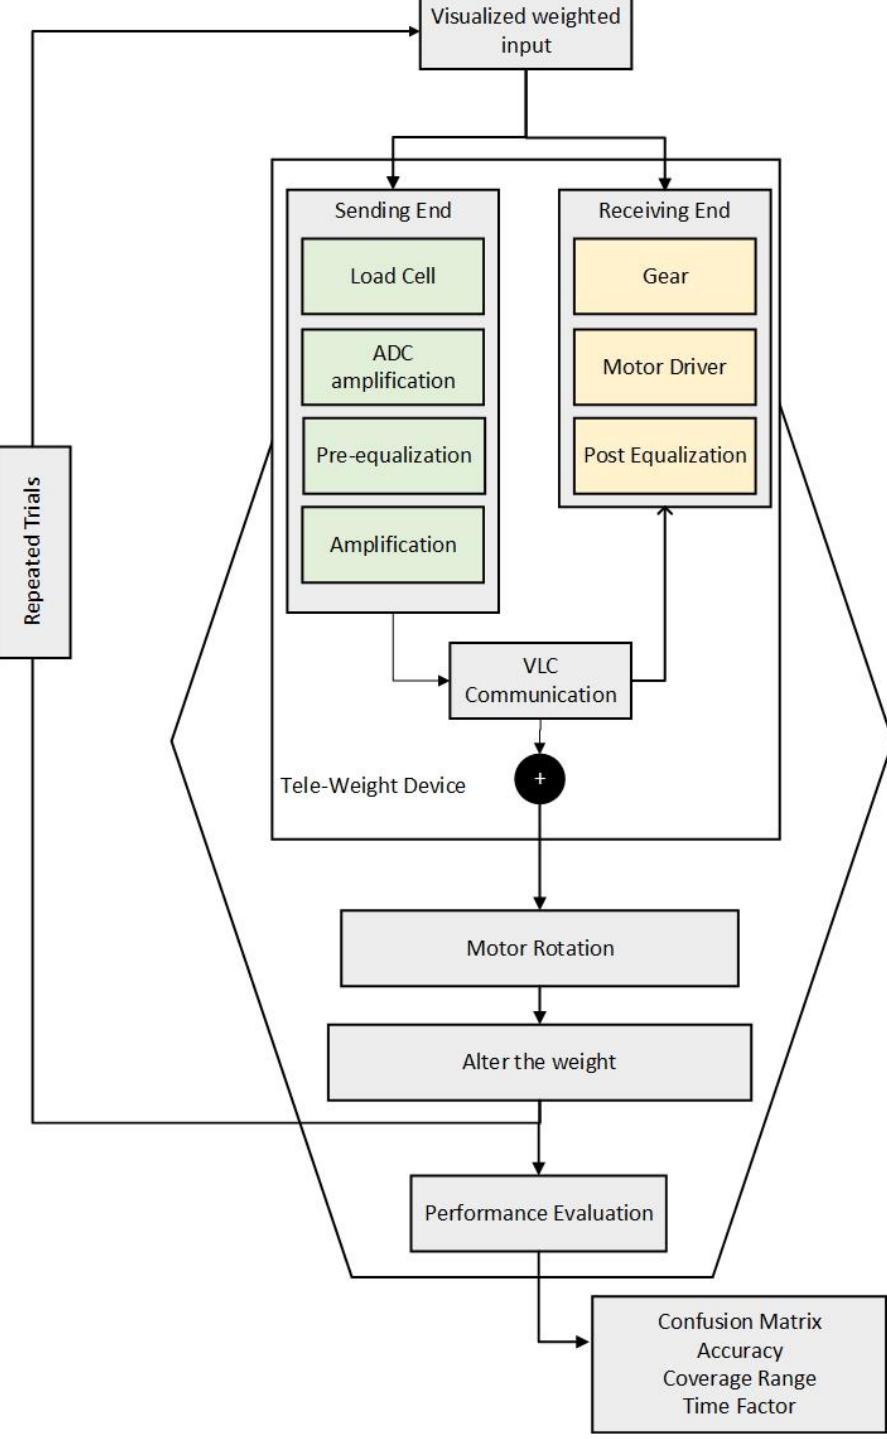
Figure 5. Block diagram for performance evaluation approach.